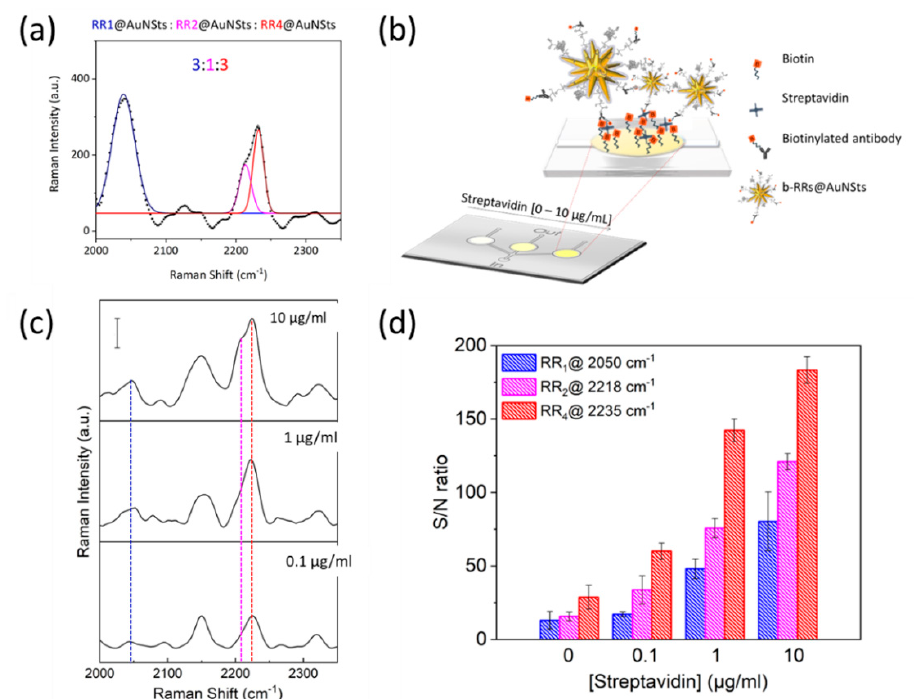
Figure 8. Proof-of-concept experiments implemented to test RRs@AuNSts bioorthogonal capability and potential for multiplexing in standard biotin-avidin assays. ( a ) Multi-component SERS spectra and corresponding deconvolution acquired for RRs@AuNSts mixed solution (black dotted line represents raw data; blue continue line is the fitting for peak of RR 1 ; magenta continue line is the fitting for the peak of RR 2 ; red continue line is the fitting for the peak of RR 4 ; continue black line represents the cumulative fit peaks). ( b ) Schematic representation of the biotin–avidin immunoassay sandwich tests implemented to prove potential RRs multiplexing exploitation. ( c ) Corresponding average SERS spectral response acquired at decreasing concentrations of streptavidin. Scale bar is 50 counts. ( d ) Raman intensity of each bioorthogonal peak showing the same linear trend for all the SERS nanoprobes tested ( n = 3; error bars represent s. d.).